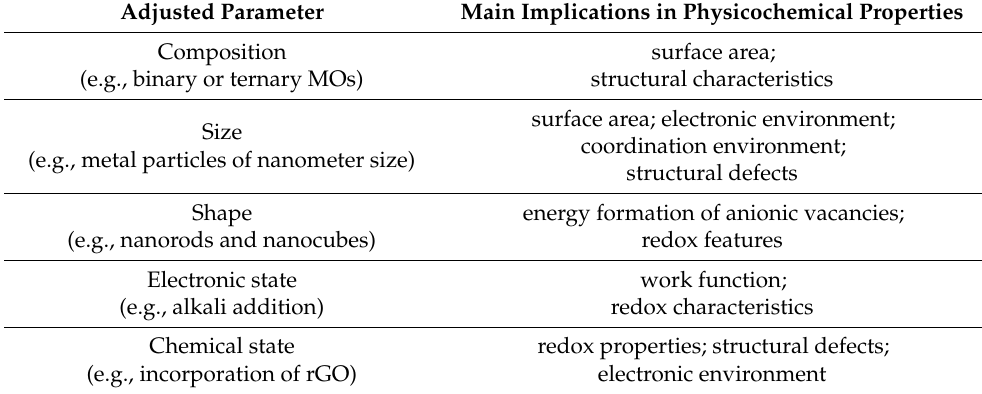
Table 1. Adjusted parameters and their implications in the physicochemical characteristics of metal oxides.